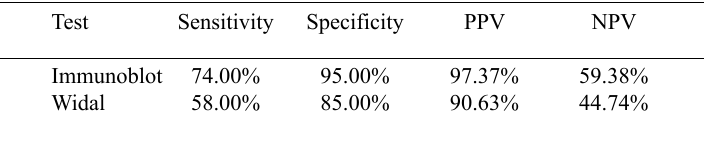
Table 2. Comparision of results among Widal and